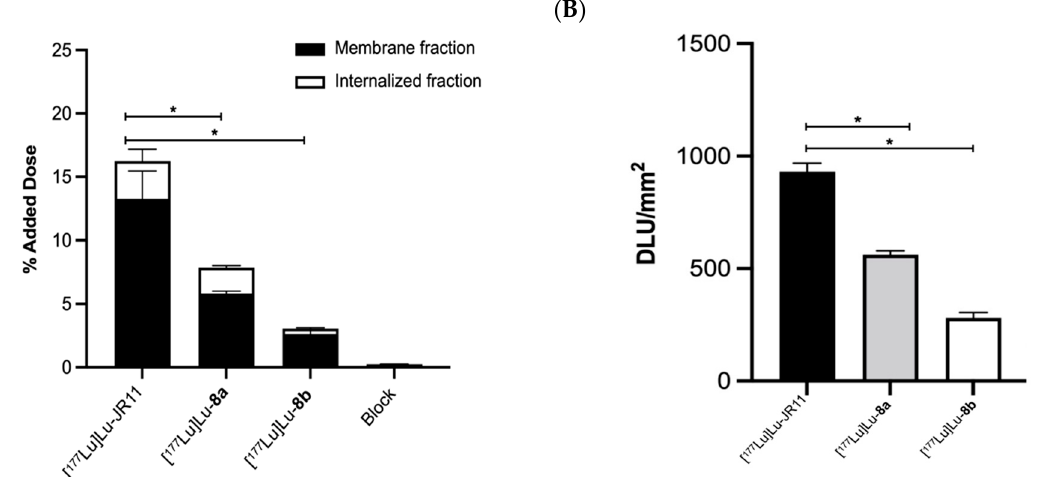
Figure 1. Uptake and internalization of compounds [ 177 Lu]Lu- 8a , [ 177 Lu]Lu- 8b and [ 177 Lu]Lu-JR11- in ( A ) U2OS-SSTR2 cells and ( B ) H69 tumor tissues expressing SSTR2. Quantification of the autoradiography images was performed and expressed as DLU/mm 2 . * p < 0.05.